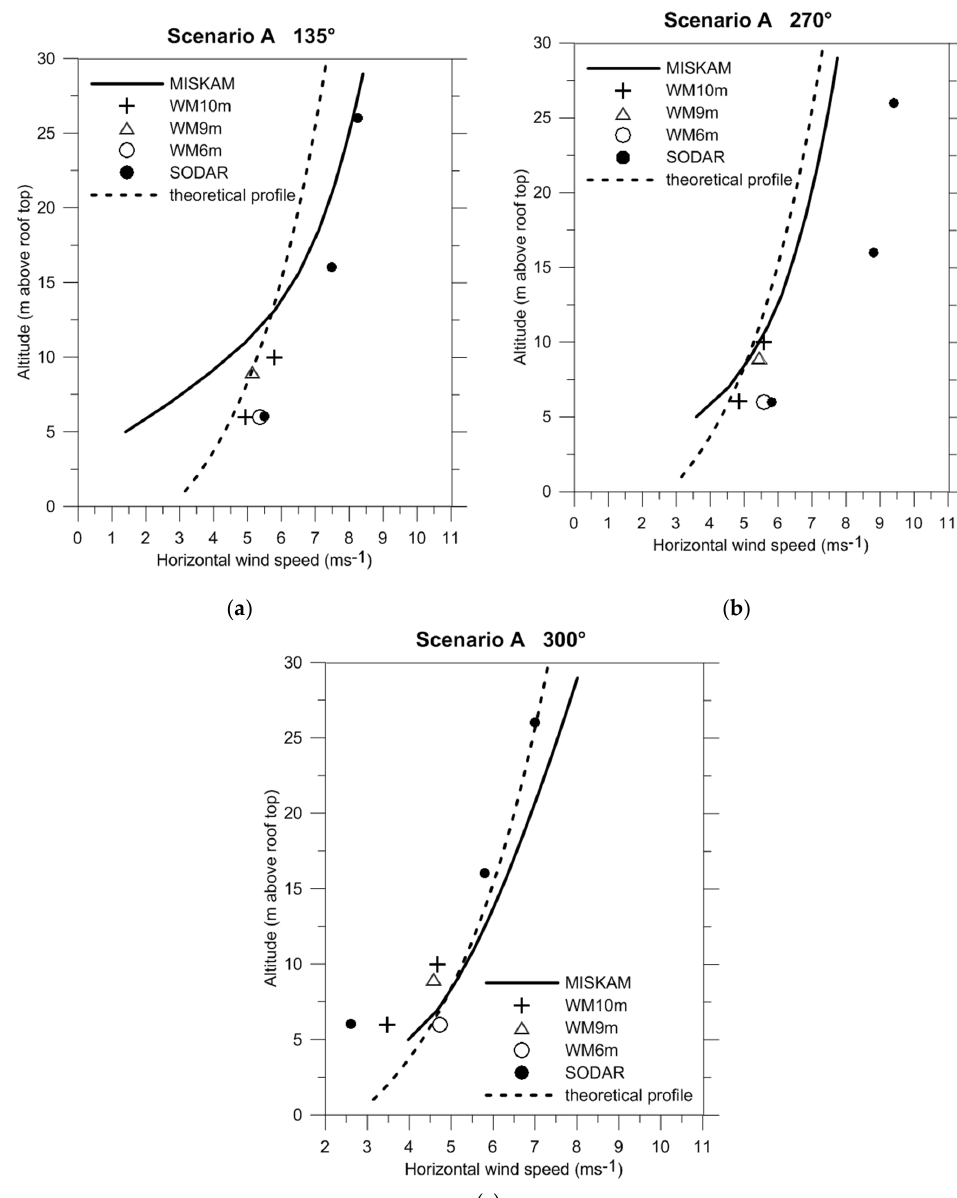
Figure 5. Vertical profiles of wind speed above roof top of the building ENERGYbase (19 m AGL) from mast and SODAR measurements, simulated with the model MISKAM for an upper boundary condition of 10 ms −1 wind speed at 100 m AGL and wind direction ( a ) 135°, ( b ) 270° and ( c ) 300° at 100 m AGL for the building configuration of scenario A (Figure 4a) and calculated using equation 1 (theoretical profile) with u* = 1.0 ms -1 , z 0 = 1.9 m and z d = 13.3 m. Under southeasterly flow conditions (135°), the mast measurements were on average in agreement with the theoretical wind profile (Figure 5a). The wind measurements at 6 m above roof at the two masts WM6m and WM10m were on average similar under these flow conditions. Furthermore, hardly any vertical variation was found from the mast measurements at 6 m, 9 m and 10 m above the roof. With southeasterly winds, the mast measurements were representing the flow conditions at the building center and close to the leeward side of the building (Figure 2). The mean